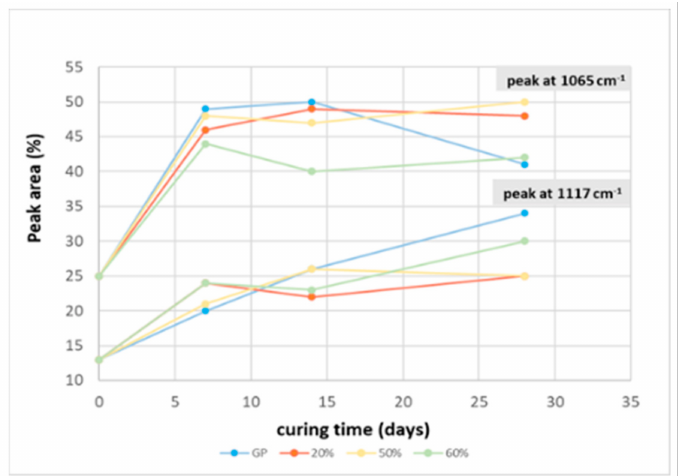
Figure 8. Comparison of the peak area determined from the deconvoluted DOSPM of FT-IR spectra of the two main peaks (1065 and 1117 cm − 1 ) for MK (taken as reference value on y -axis), GP, GP/WG (20, 50 and 60%) samples at different curing